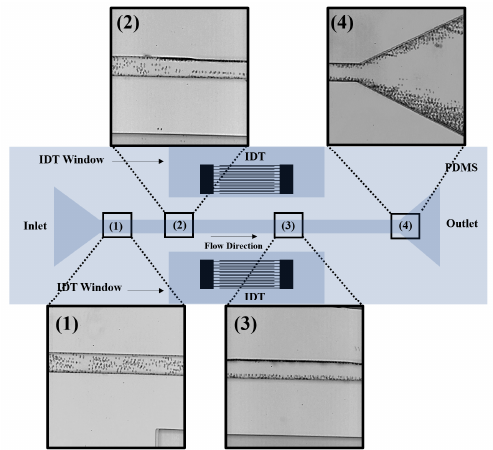
Figure 12. Experimental results of focusing PS particles at pressure nodes under SSAW in the microchannel. (1): microscopic image of PS particles at the inlet section of the platform. PS particles are not yet exposed to SSAW. (2): microscopic image shows the moment PS particles are exposed to SSAW. The exposed PS particles migrate in a lateral direction toward the position of the SAW-created pressure nodes. (3): microscopic image depicts the equilibrium location of PS particles after exposure to SSAW. (4): microscopic image of PS particles at the platform’s outlet after they have been focused.